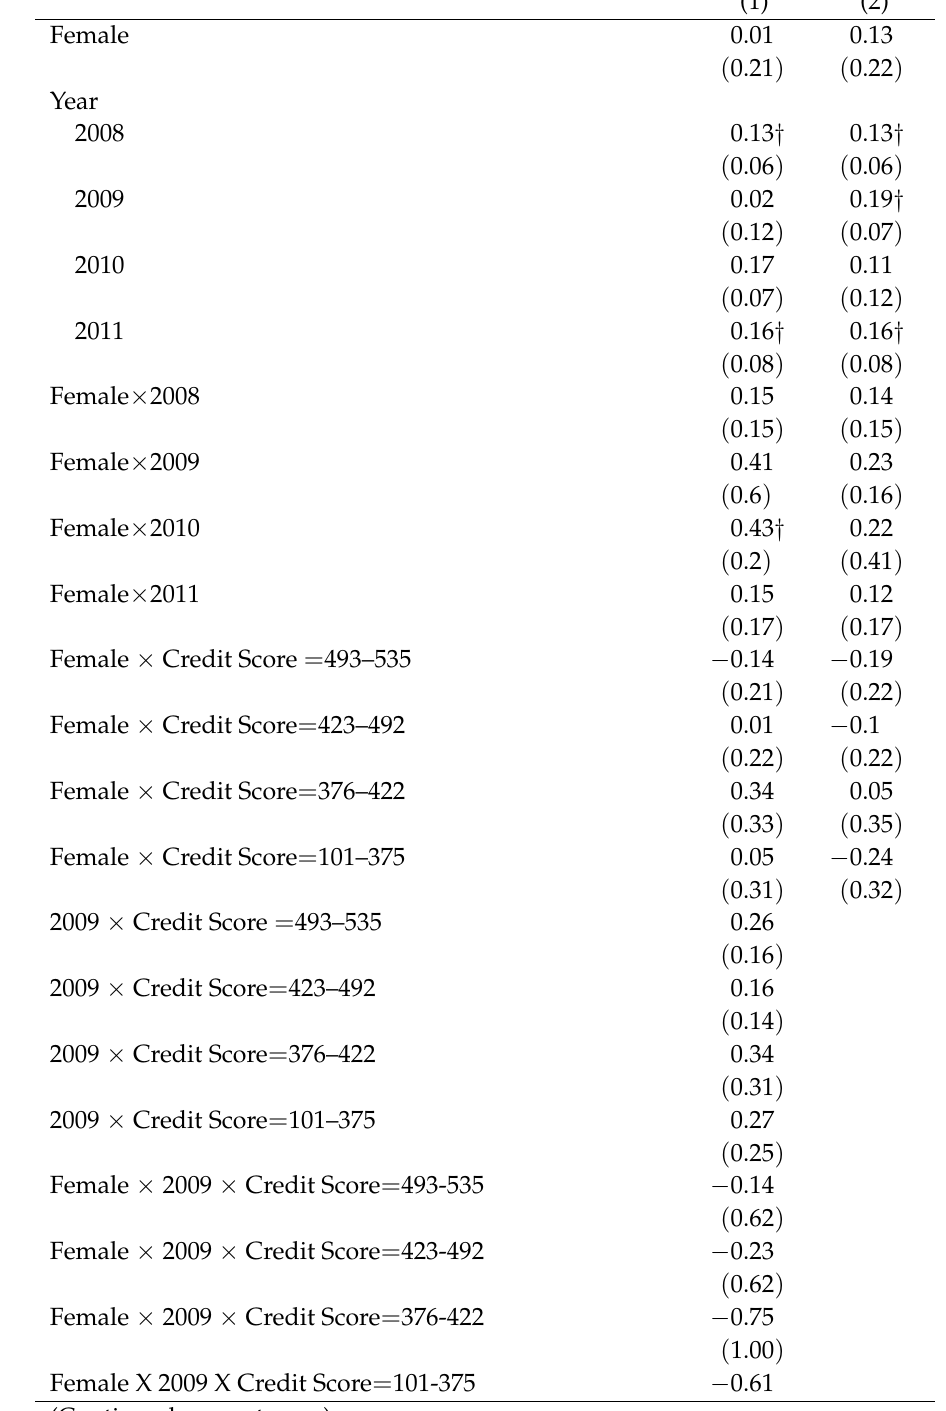
Table 5: Estimated Coefficients from Ordinary Least Squares Regression Models Testing Gender Differences in Interpretation of Credit